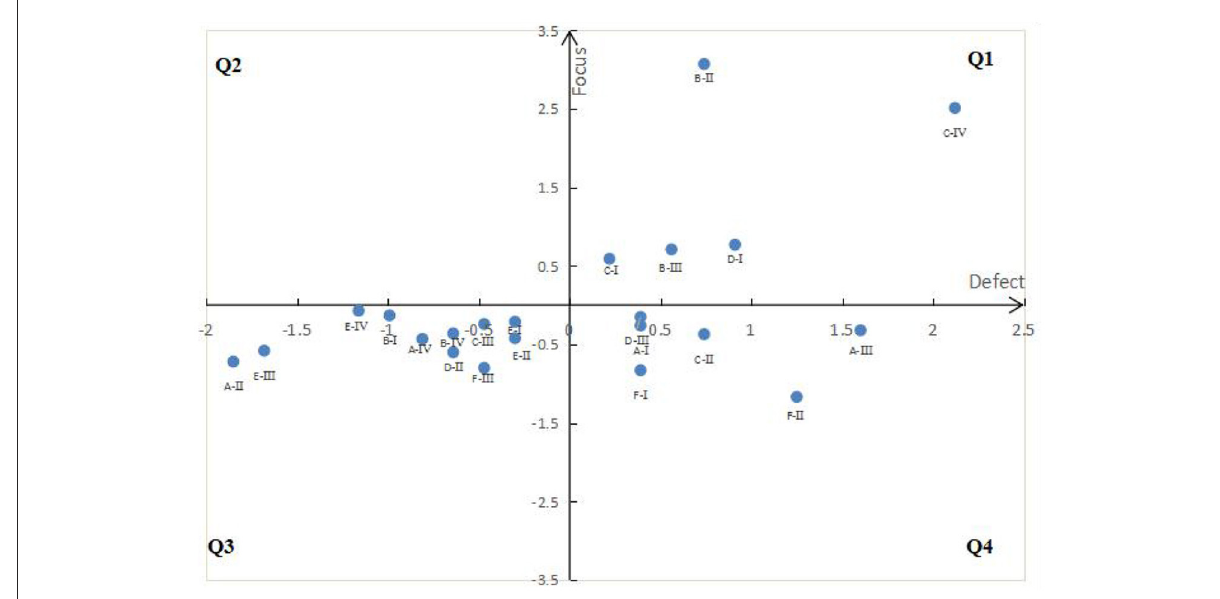
FIGURE6 DFA diagram of defect detail.